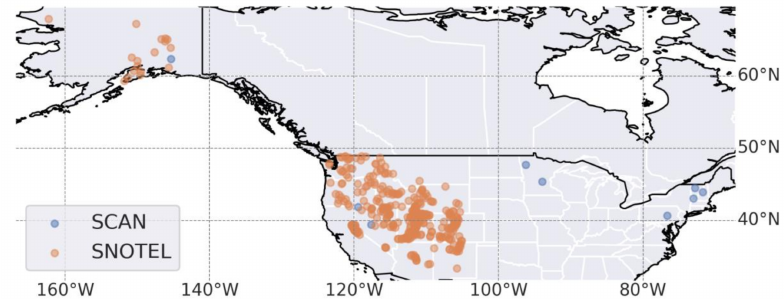
Figure 2. A map of the locations of Snow Telemetry (SNOTEL) (orange) and Soil Climate and Analysis Network (SCAN) (blue) ISMN (International Soil Moisture Network (ISMN)) stations used in this